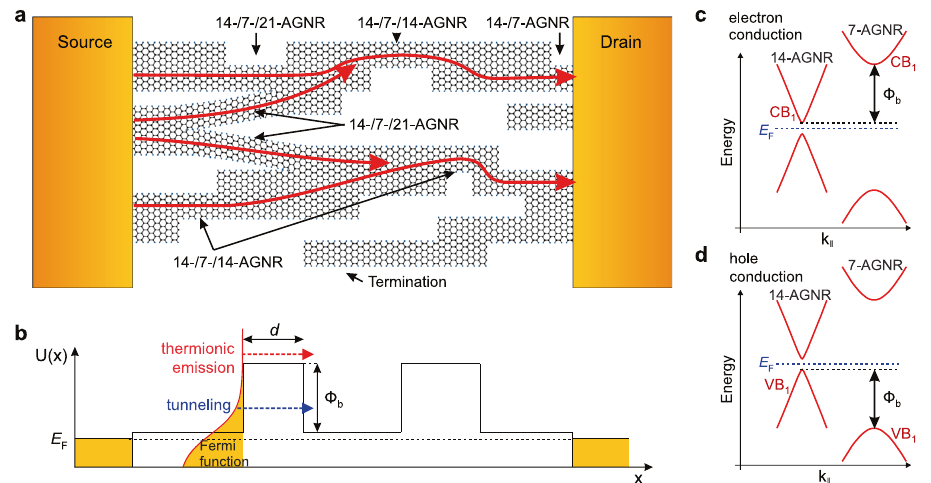
Fig. 1 Electronic structure of GNR heterojunctions. a Schematic illustration of the aligned GNR heterojunctions integrated into the device. Lateral fusion of 7-AGNRs leads to the formation of quasi-metallic 14-AGNR and 21-AGNRs. When the source – drain contacts are fabricated, the remaining 7-AGNR segments act as tunneling barriers. Red arrows indicate different paths for charge transport. b Potential U ( x ) as a function of coordinate x between source and drain contacts of multiple 7-/14-AGNR heterojunctions. The Fermi level E F , the barrier height Φ b , and the barrier length d are indicated. The Fermi function shows the distribution of electrons in 14-AGNRs. Thermionic emission (red arrow) and tunneling (blue arrow) mechanisms are schematically shown. c , d Sketch of the electronic energy band dispersions of 7-AGNR and 14-AGNR. Momentum along the ribbon axis is denoted as k ∥ . The conduction and valence band edges are CB 1 and VB 1 , respectively, and determine the value of Φ b